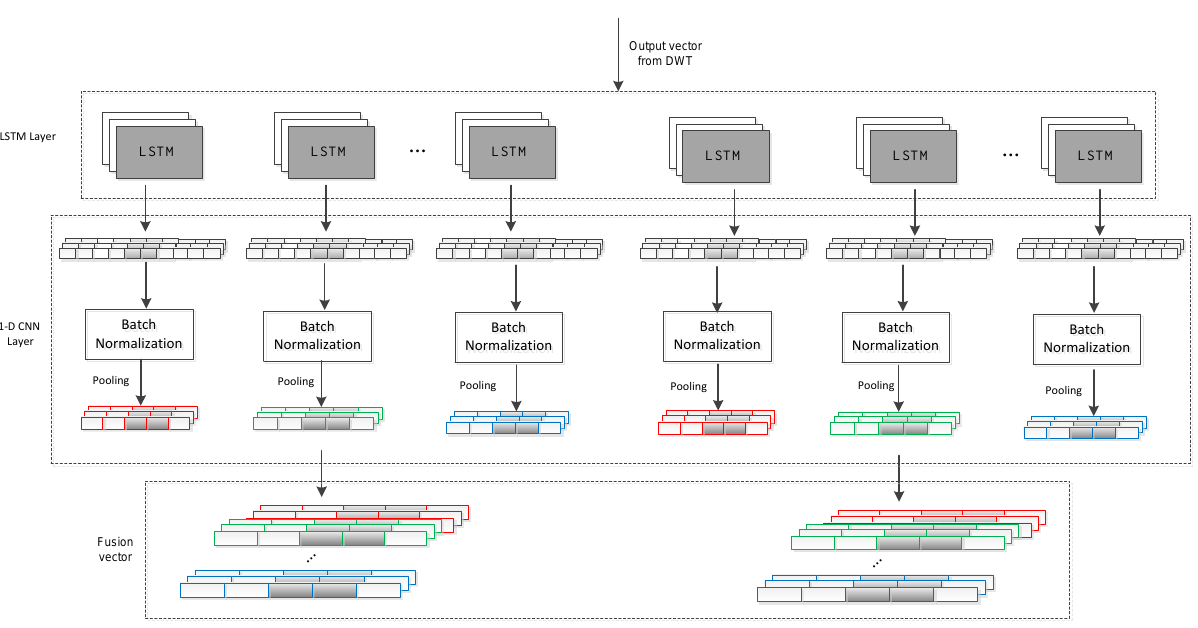
Figure 2. Single-channel sensor signal feature extraction. LSTM